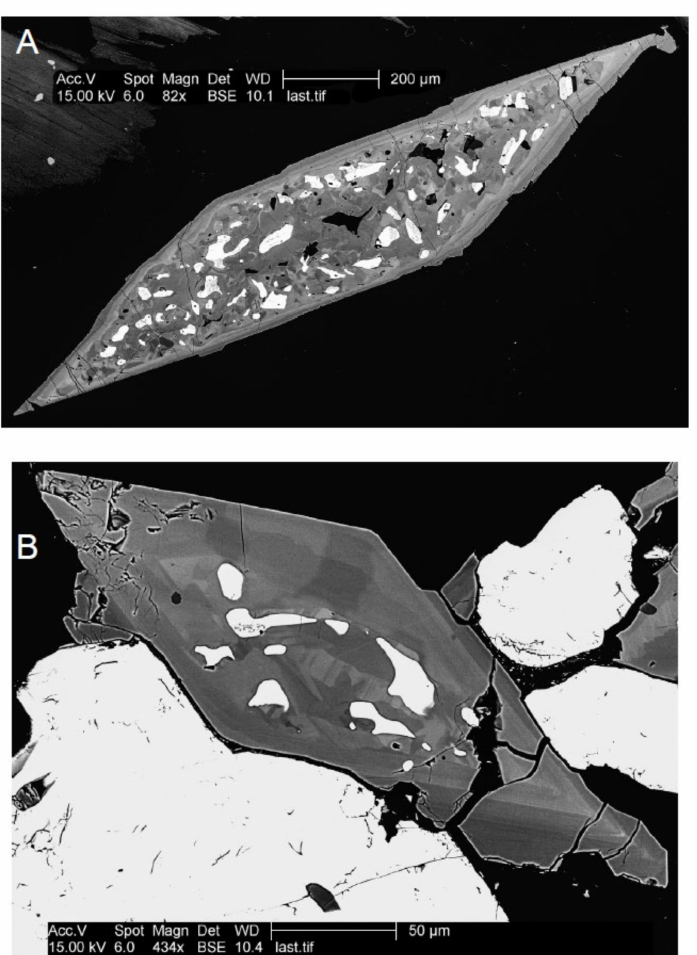
Figure 11. Backscattered electron (BSE) images of ( A ) titanite grain from the Oligocene Little Cot- tonwood stock, Utah showing patchy core zone with association with abundant Fe-Ti oxide grains overgrown by wavy light and dark oscillatory zones; ( B ) titanite grain from the Jurassic Notch Peak pluton, Utah similar to grain A above with patchy zoning and Fe-Ti oxides in the core overgrown by oscillatory-zoned